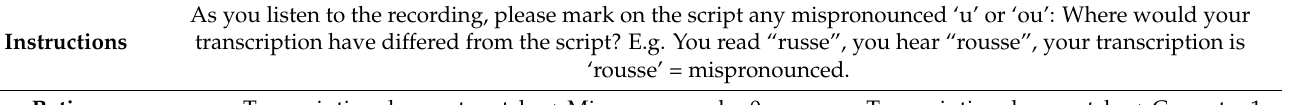
Table 2. Rating instruction for /